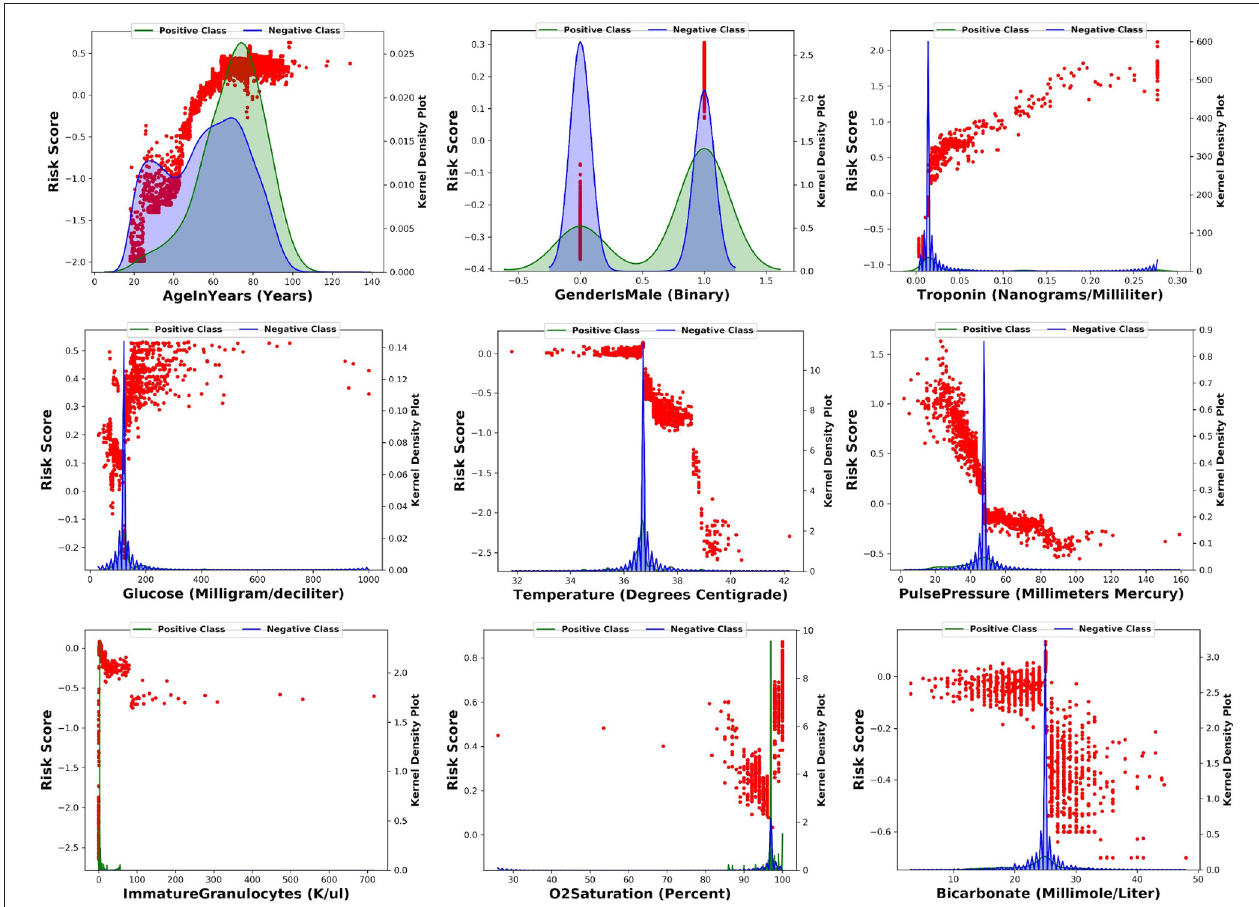
FIGURE 4 | For each of the top nine most importance input features, this figure shows the scatter plot of SHAP values against the feature